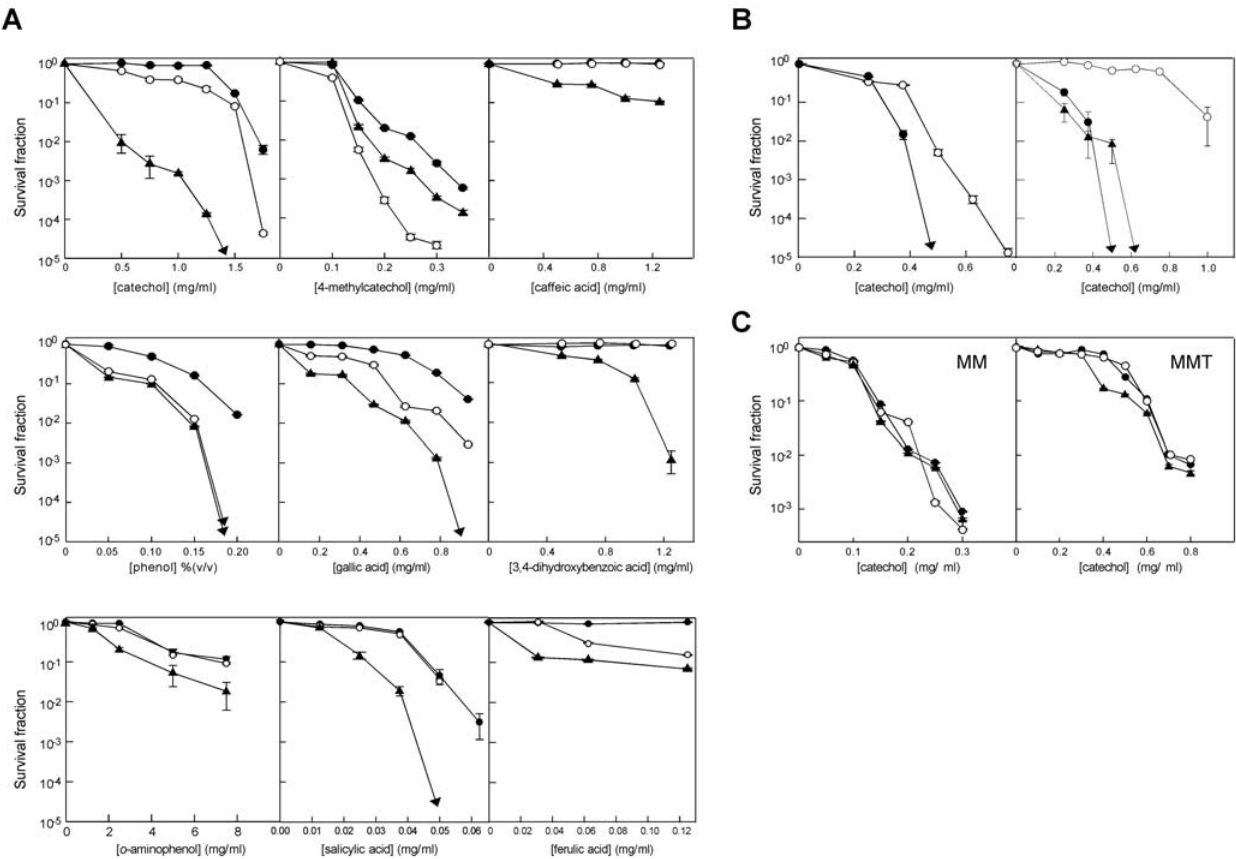
Figure 4. Sensitivity of Streptomyces to phenolic compounds. Diluted spore suspensions were plated on medium containing various concentrations of the phenolic compounds and incubated at 30 u . After 4 days, the surviving colonies were counted. Survival levels below the lowest scales in the graph are indicated by the arrows. The horizontal bars represent standard deviations. A. Effect of melC and melD in S. coelicolor . Medium: R5. Filled circles, M145; open circles, HY69; filled triangles, M145/pIJ702-117. B. Effect of melC in S. avermitilis and S. antibioticus . Medium: R5. Left panel, S. avermitilis (filled circles, wild type; open circles, D melC mutant B19). Right panel, S. antibioticus (filled circles, wild type; open circles, D melC mutant YU5; filled triangles, YU5-117, a YU5 derivative containing an insert of melC from pIJ702-117). C. Effect of media. Left, MM; Right, MMT. The symbols are as in A.